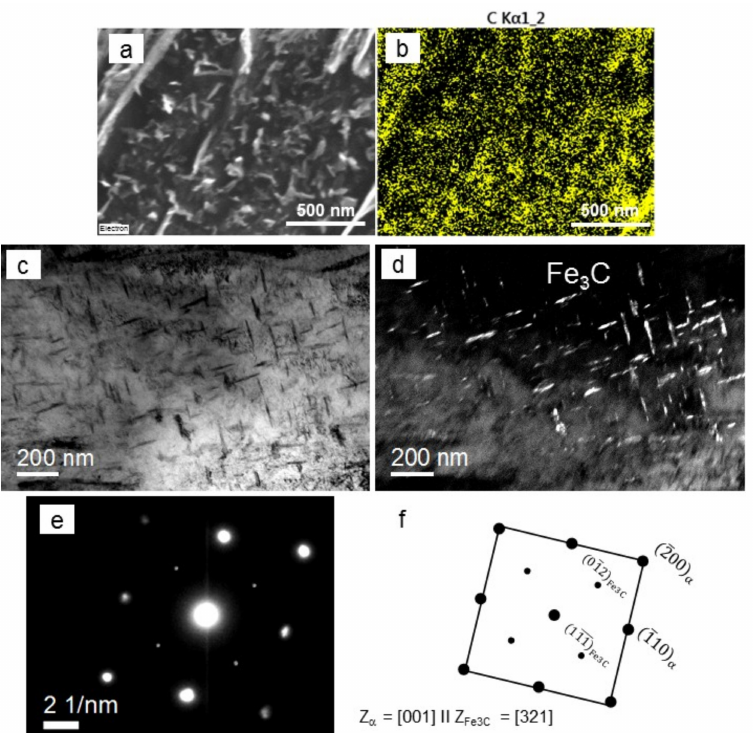
Figure 12. Fe 3 C particles in the base metal of Steel L: ( a , b ) SEM image with the corresponding EDS carbon map; ( c , d ) bright and dark field TEM images; ( e ) diffraction pattern corresponding to images ( c , d ); and ( f ) indexing of the diffraction pattern shown in ( e ).